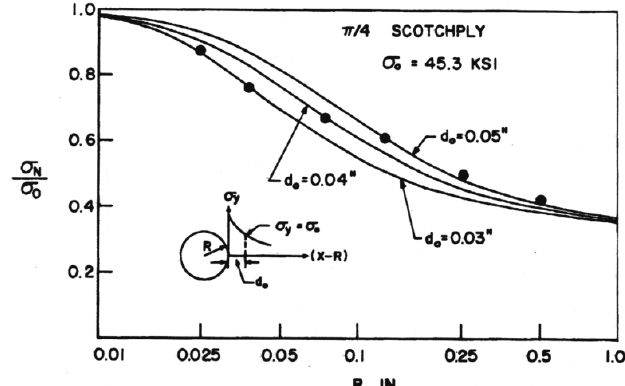
Figure 2: Data and predictions (using the point method) from Whitney & Nuismer [3], showing the effect of hole radius on fracture strength (nominal stress, normalised by the plain-specimen strength) in a quasi-isotropic glass/epoxy laminate. The three prediction lines were drawn using slightly different values of the critical distance, d o which is equivalent to L/2.